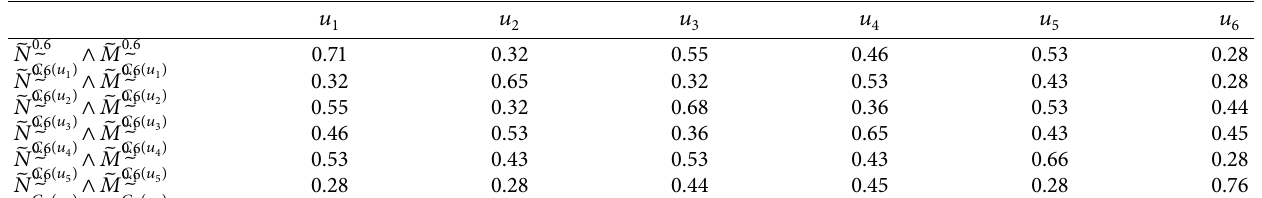
∧ 􏽥 M 0 . 6 􏽥 . C 1 ( u i ) C 1 ( u i )